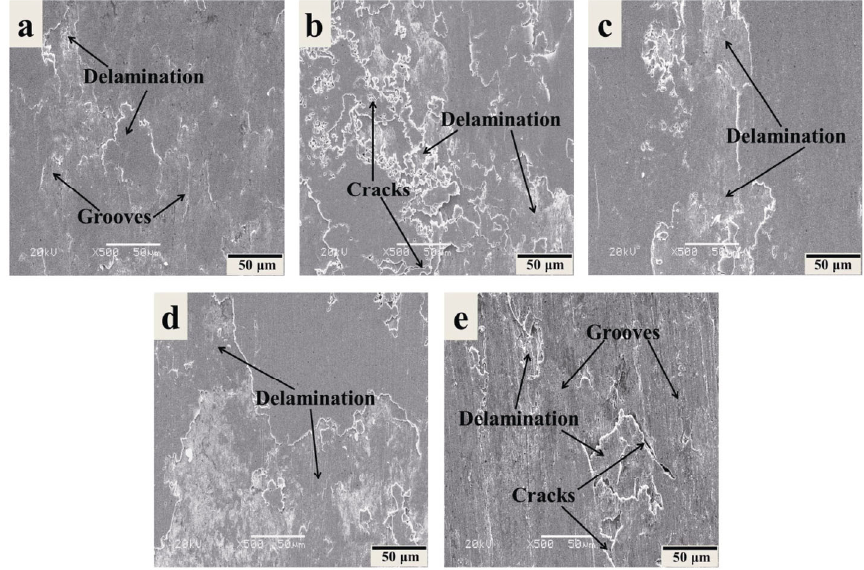
Fig. 7 SEM images of the worn surfaces of composite G0.5: (a) 25 ºC, (b) 200 ºC, (c) 400 ºC, (d) 600 ºC, and (e) 800